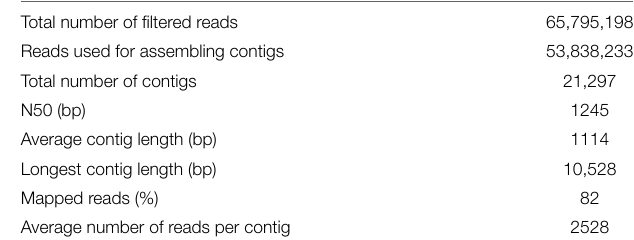
TABLE 1 | Statistics of RNA-Seq and de novo assembly ( 47 × 300 ) of Vicia faba transcriptome